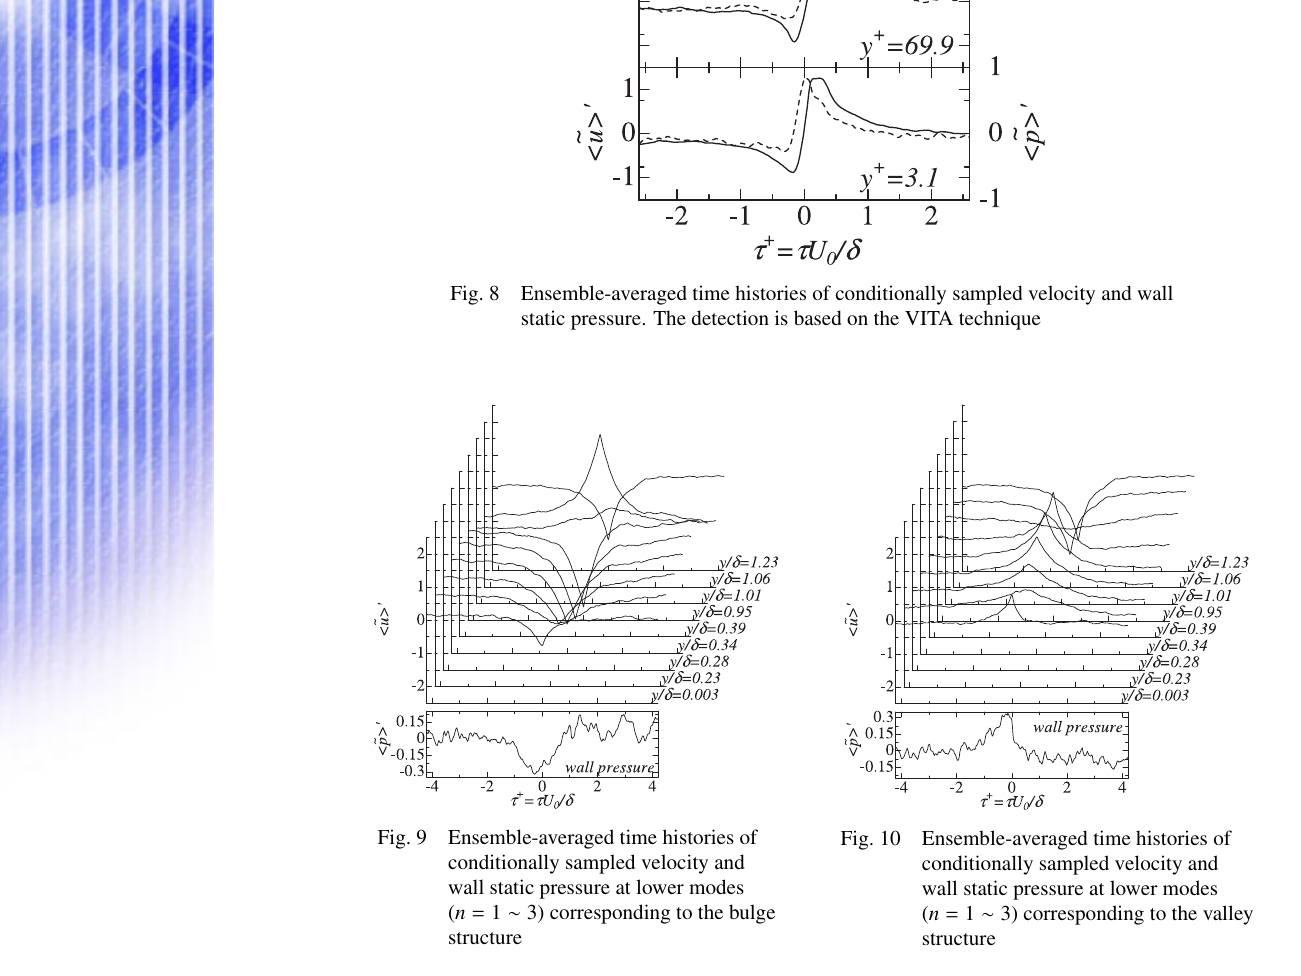
(cid:7) ˜ p ( τ ) (cid:8) (cid:3) , respectively. τ is the time lag from the detection time at which the